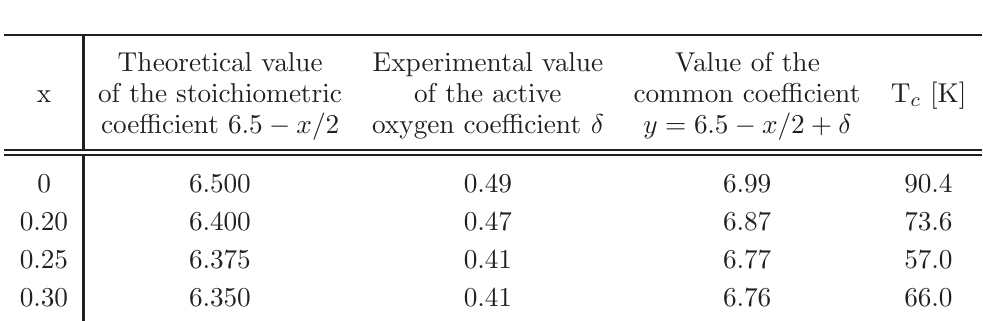
Table 4 Results for the oxigen coefficient in Er 1 − x Ca x Ba 2 Cu 3 O y .